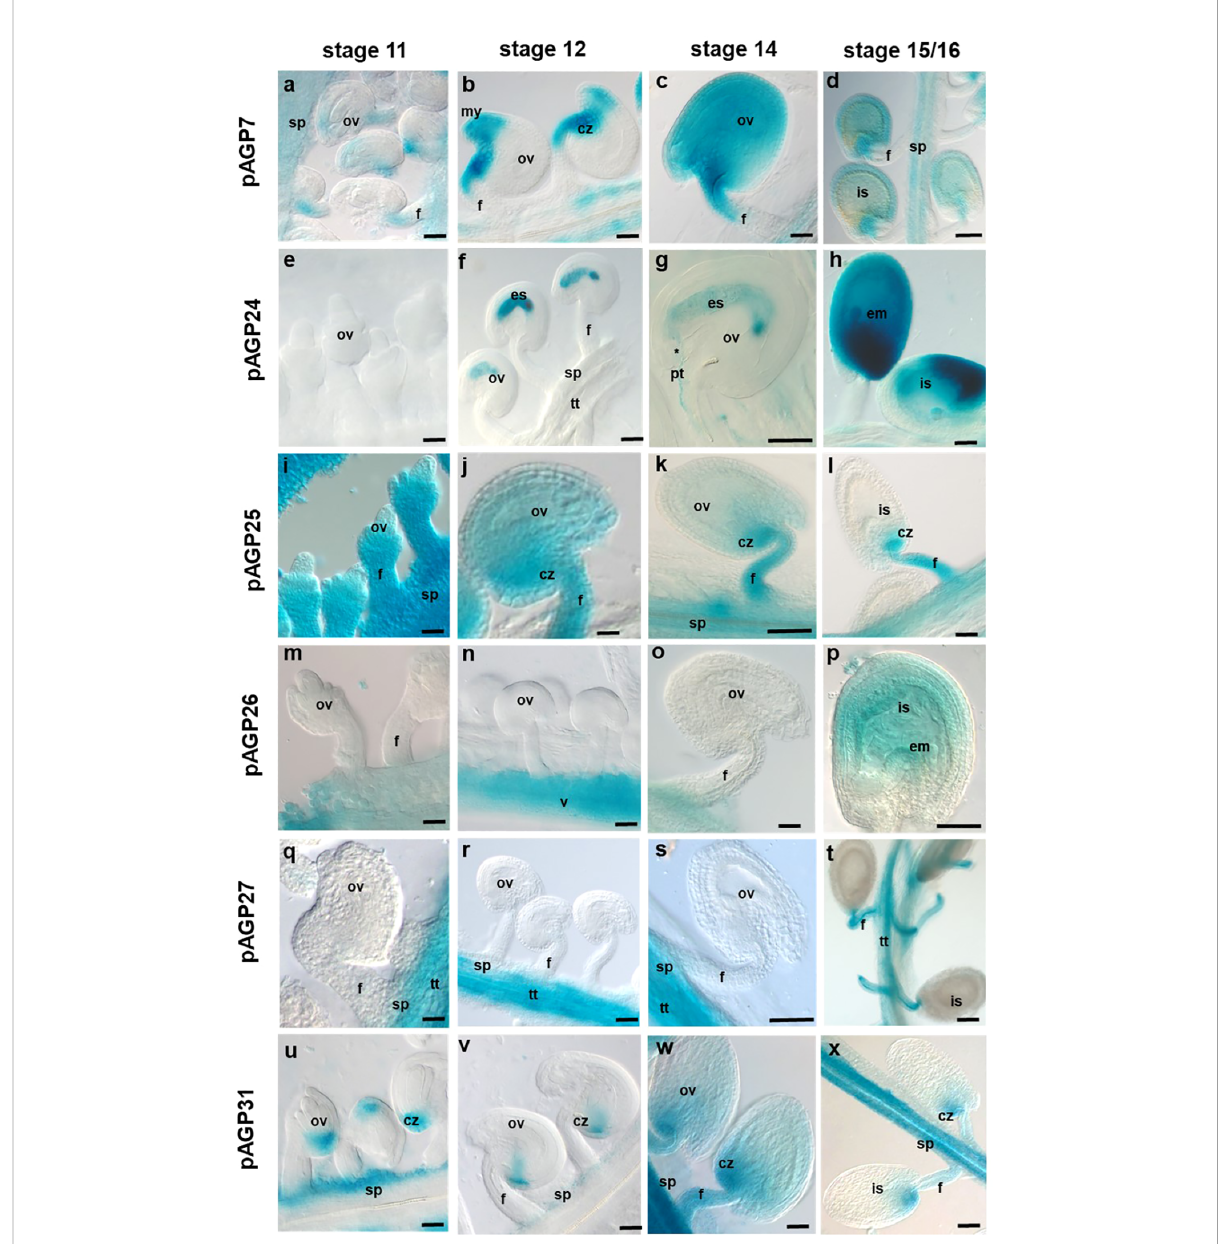
FIGURE 3 Histochemical localization of GUS activity in transgenic Arabidopsis ovaries expressing different pAGP : GUS fusion constructs. (A – D) GUS activity driven by the AGP7 promoter at different stages detected in the chalaza region, micropyle and funiculus (A, B, D) and diffuse in all ovules (C) . (E – H) GUS activity driven by the AGP24 promoter at different stages, absent in ovules in stage 11 and observed in embryo sac in stages 12 and 14 (F, G) and diffused in all immature seeds (H) . (I – L) GUS activity driven by the AGP25 promoter was identi fi ed in the ovules, including the funiculus, septum and chalaza pole. (M – P) GUS activity driven by the AGP26 promoter at different stages was observed in pistil valves and absent in the ovules; some diffuse expression was detected in stage 16 in immature seeds (P) . (Q – T) GUS activity driven by the AGP27 promoter visible in the transmitting tract and septum but absent in the ovule region in stages 11-12 (Q, R) and in funiculus in stages14-15/16 (S, T) . (U – X) GUS activity driven by the AGP31 promoter in different developmental stages visible in the septum and chalaza pole in stages 11 and 12 (U, V) and in funiculus in stages 14 and stage 15/16 (X, Y) . Flowers of stages 11, 12, 14 and 15/16 (Smyth et al., 1990) were used in this study. cz, chalaza; f, funiculus; is, immature seed; ov, ovule; pg, pollen grain; pt, pollen tube; s, stigma; st, style; sp, septum; tt, transmitting tract; v, valves. Scale bars, 50 m m (A – J, L – O, Q, R, T, U, V, W, X) ; 20 m m (G, K, P, S)